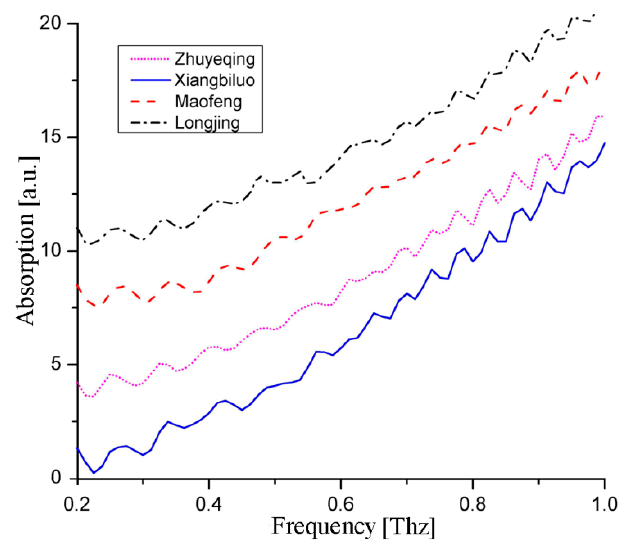
Figure 2. THz absorption spectroscopy of different green tea.